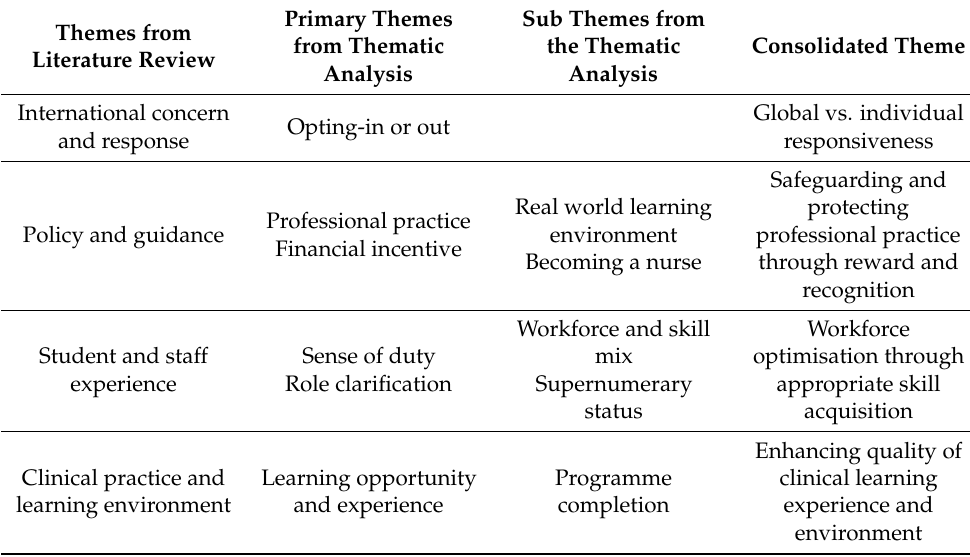
Table 7. Synthesis of findings from literature review and thematic